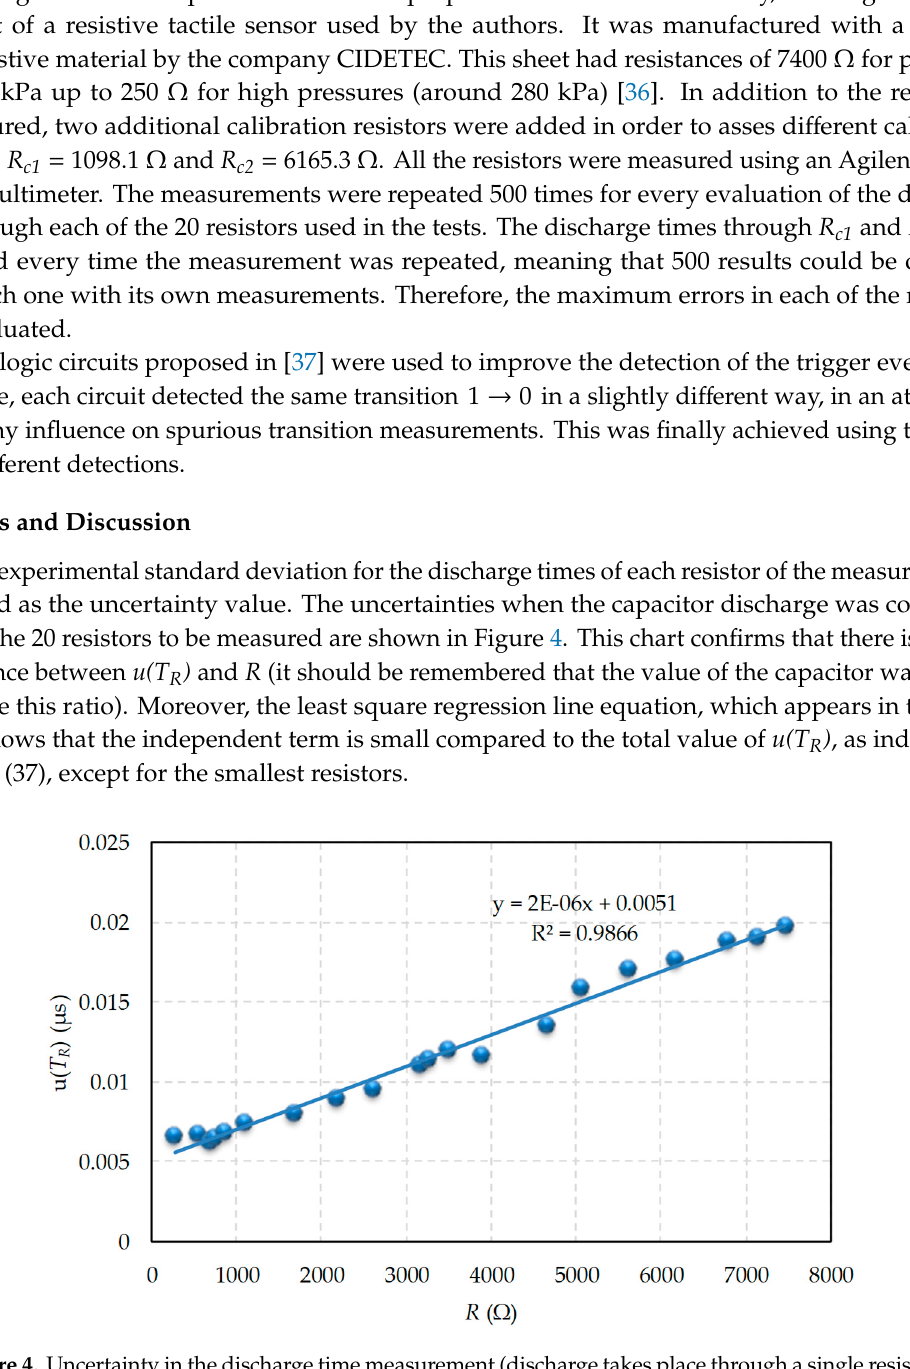
Figure 4. Uncertainty in the discharge time measurement (discharge takes place through a single resistor).